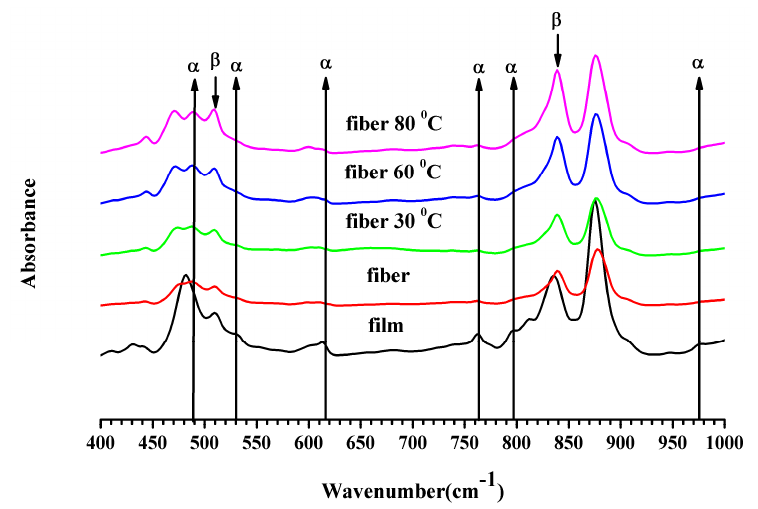
Figure 5. IR spectra of film and fiber P(VDF-HFP) for wavenumbers from 400 to 1000 cm − 1 .